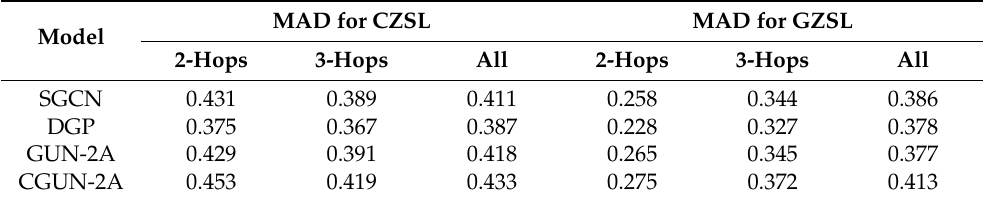
Table 3. The MAD values of some GCN-based methods on the ‘2-hops’, ‘3-hops’ and ‘all’ datasets with both CZSL and GZSL